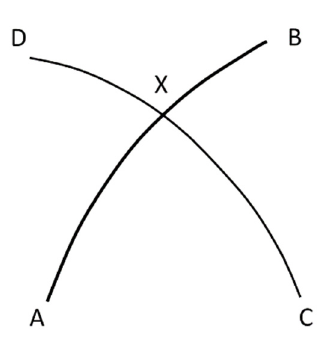
Figure 1. Intersection of geodesics AB and CD.